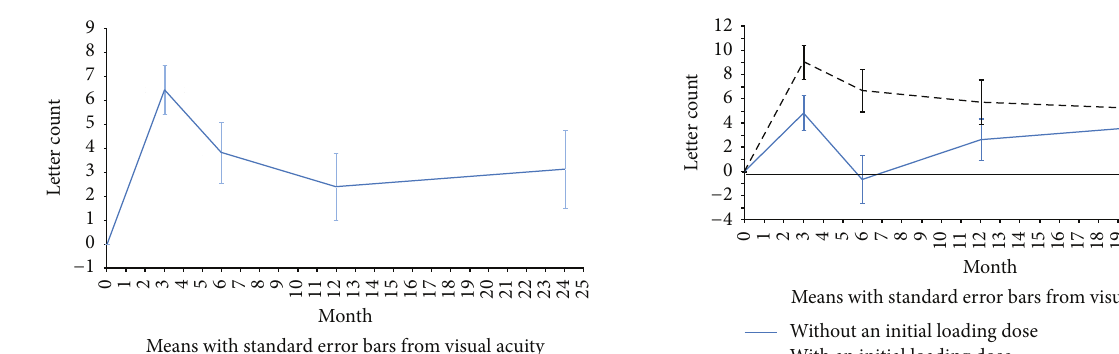
Figure 2: Changes in visual acuity depending on the administration of an initial loading